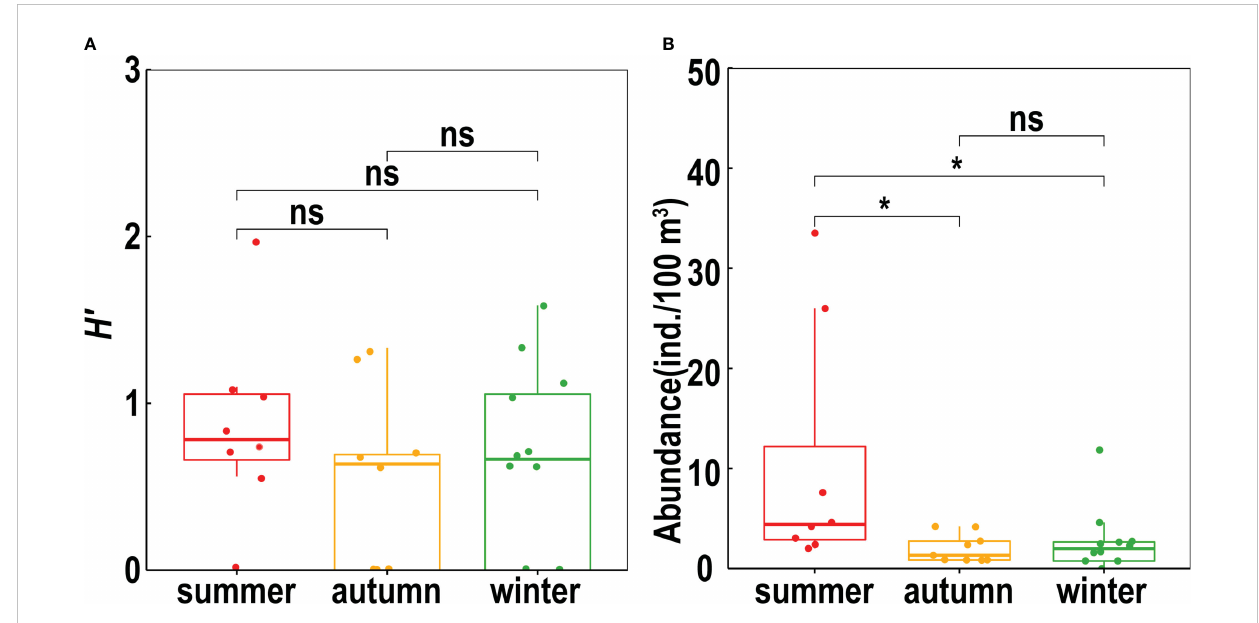
FIGURE 3 Temporal variation of the Shannon-Wiener index (A) and larvae abundance (B) from summer to winter (*, signi fi cant; ns, no signi fi